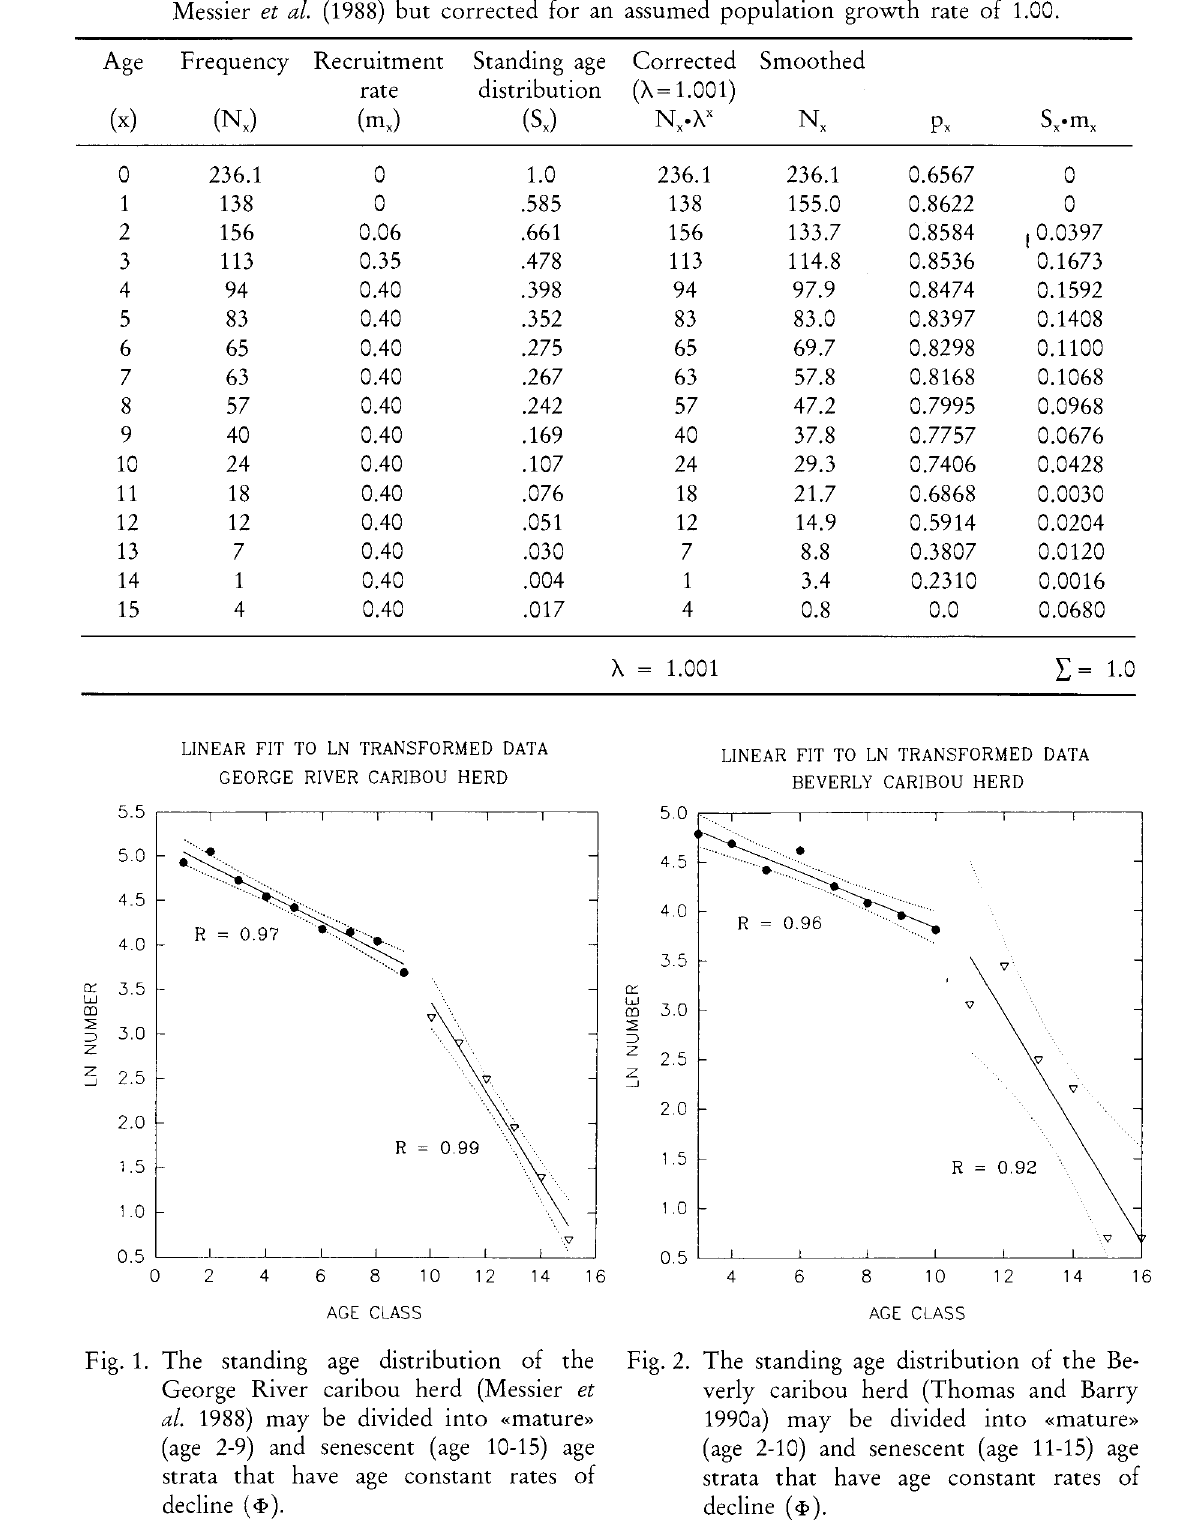
Table 3 A life table for the George River caribou herd based on the same information as given in Messier et a /. (1988) but corrected for an assumed population growth rate of 1.00.